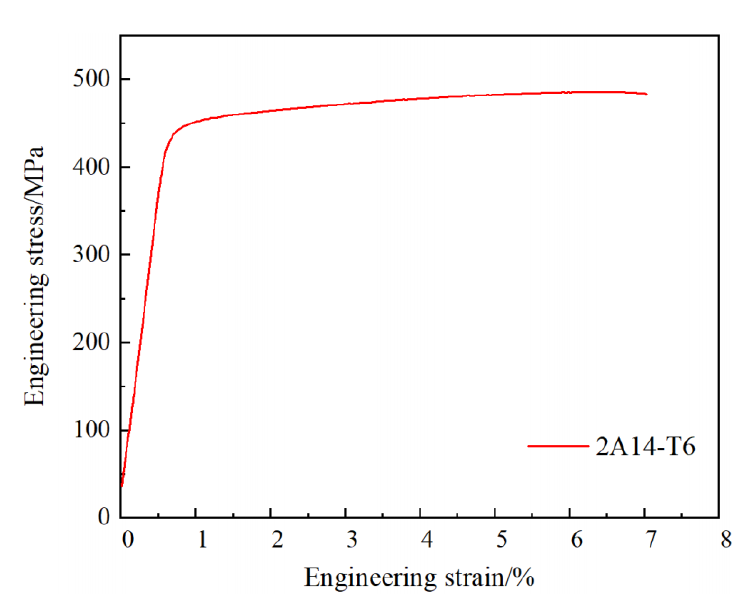
Figure 2. Engineering stress–strain curve of the 2A14 aluminum